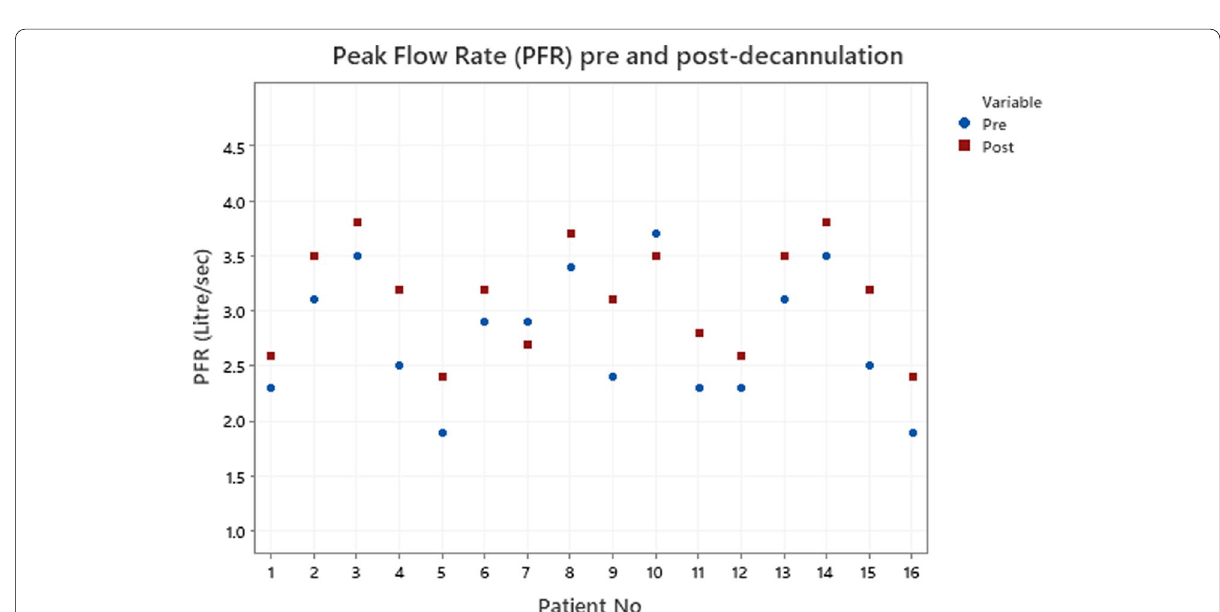
Fig. 2 Plot distribution of peak flow rate in all studied subjects before and after